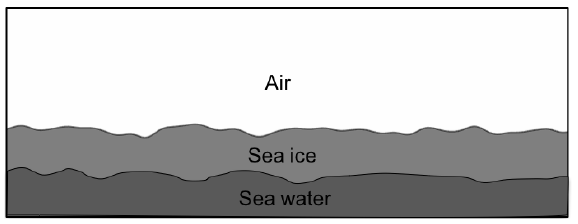
Figure 7. Geometry illustrating the newly formed sea ice considered for the scattering